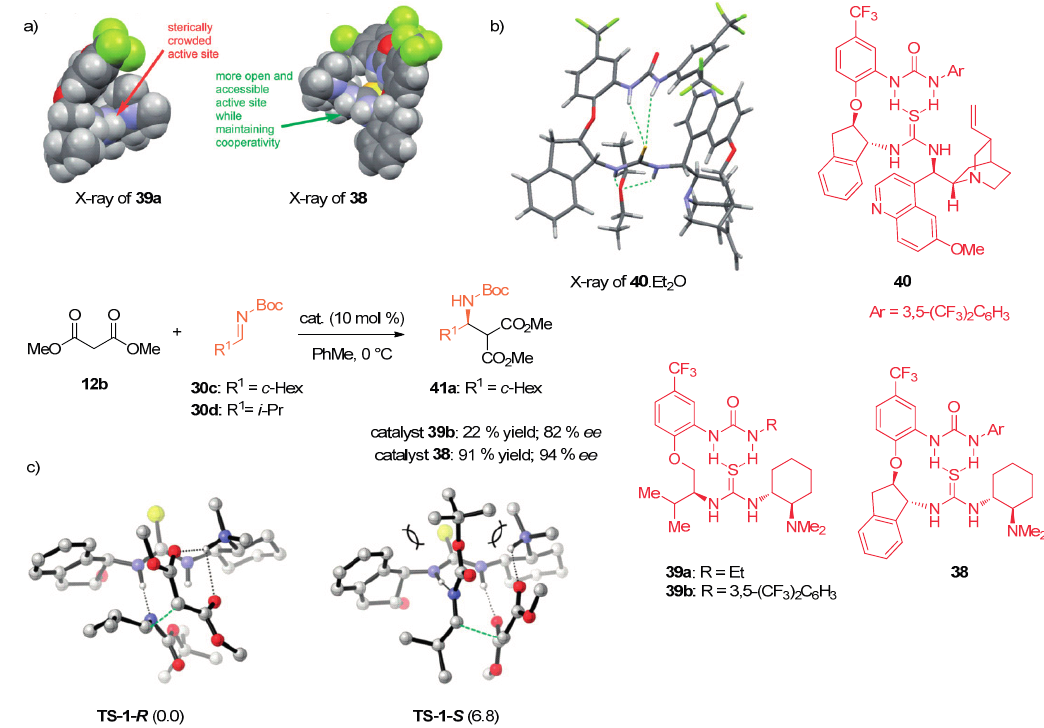
Figure 10. Catalyst design and more accessible thiourea moiety in 38 compared to 39a ( a ); X-ray of complex 40 .Et 2 O ( b ); DFT-calculated transition states for the Mannich reaction between imine 30d and dimethyl malonate ( 12b ) ( c ). The urea moiety of the catalyst is omitted for clarity. Computed relative energies are shown in parentheses (kcal·mol − 1 ). Adapted with permission from Ref. [35]. Copyright (2012) John Wiley and